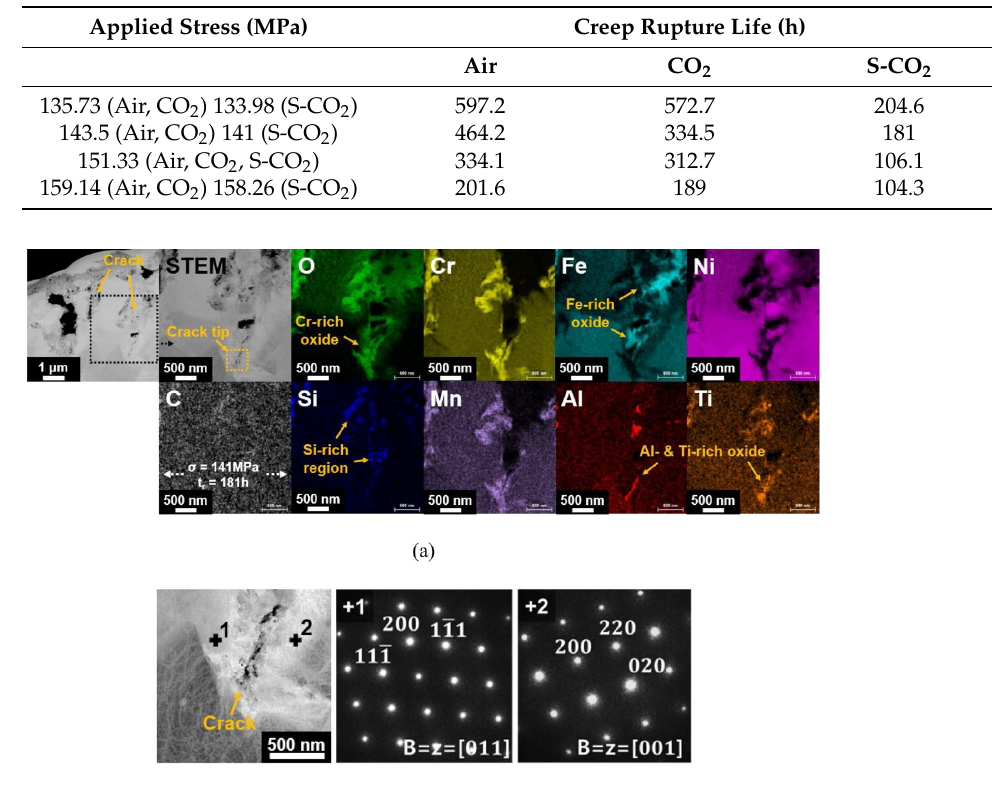
Table 2. Summary of creep rupture test results of alloy 600 in different environments. Data were obtained from reference [129]. Reproduced with permission from Elsevier.